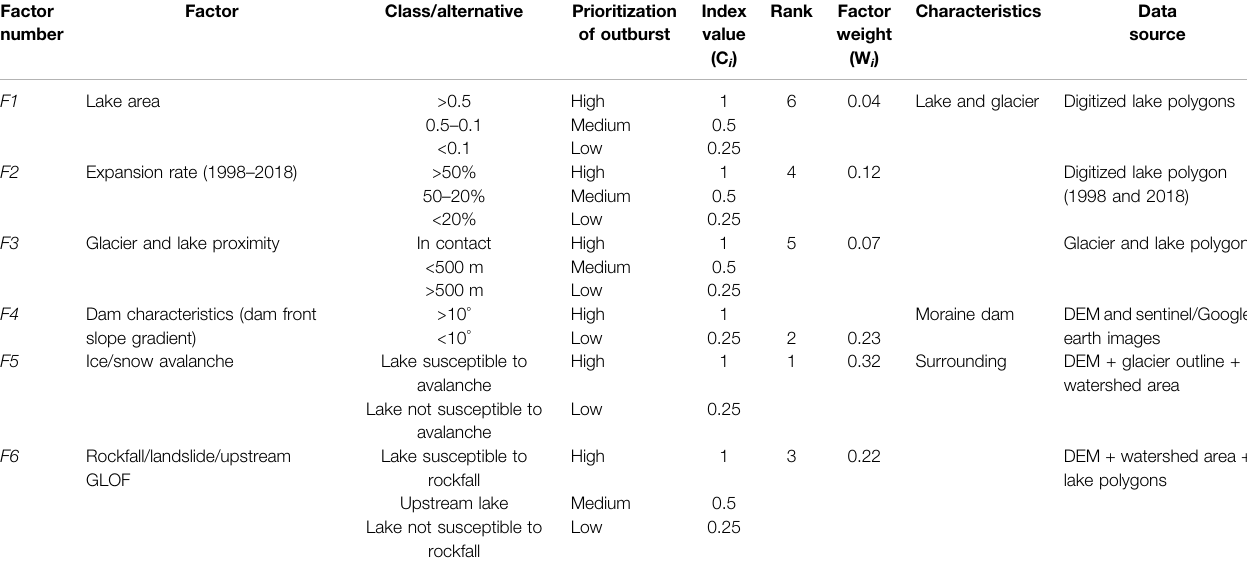
TABLE 3 | Selected factors with their classes and index values. Rank and weight of each factor are computed using the AHP method. Factor